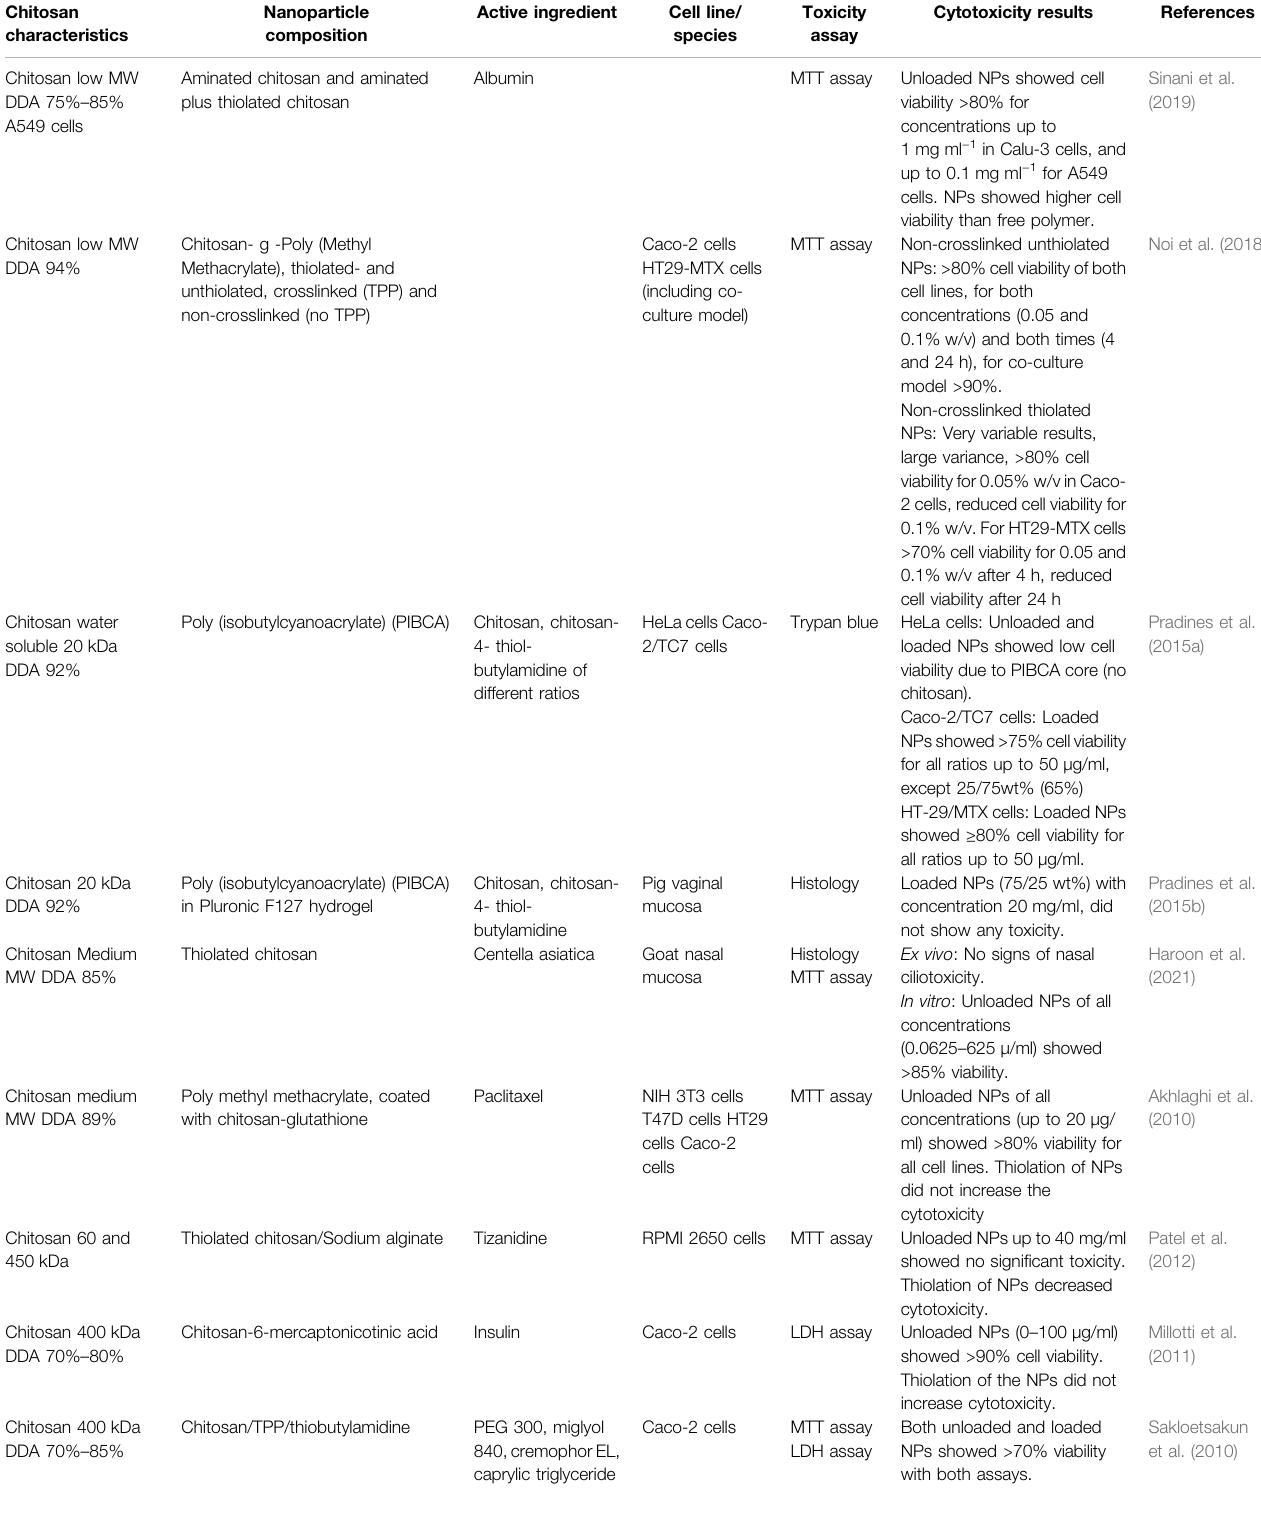
TABLE 7 | Articles on nanoparticles with thiolated chitosan, main fi